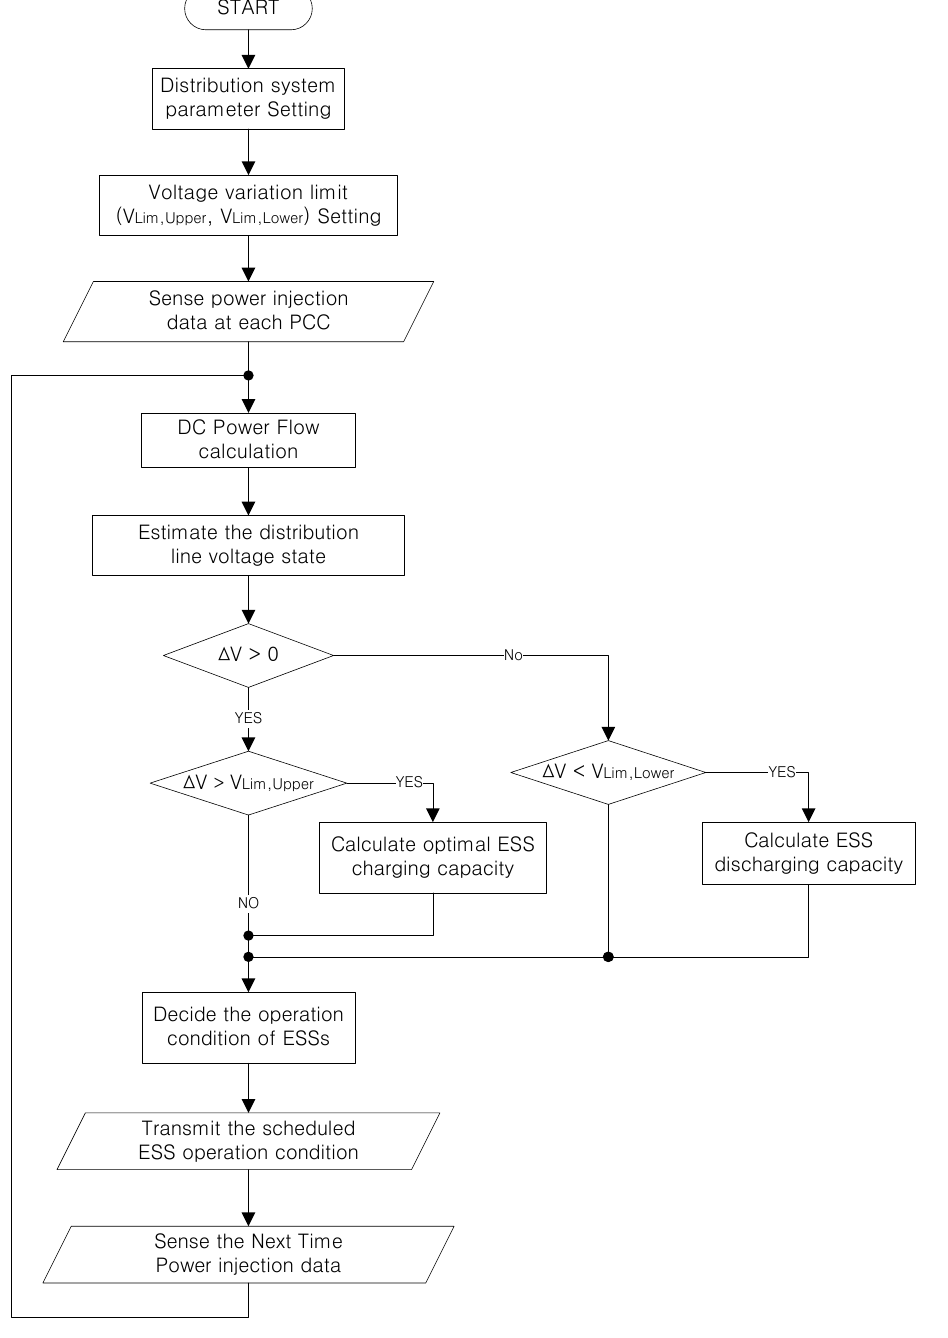
Figure 7. ESS charge scheduling algorithm for voltage